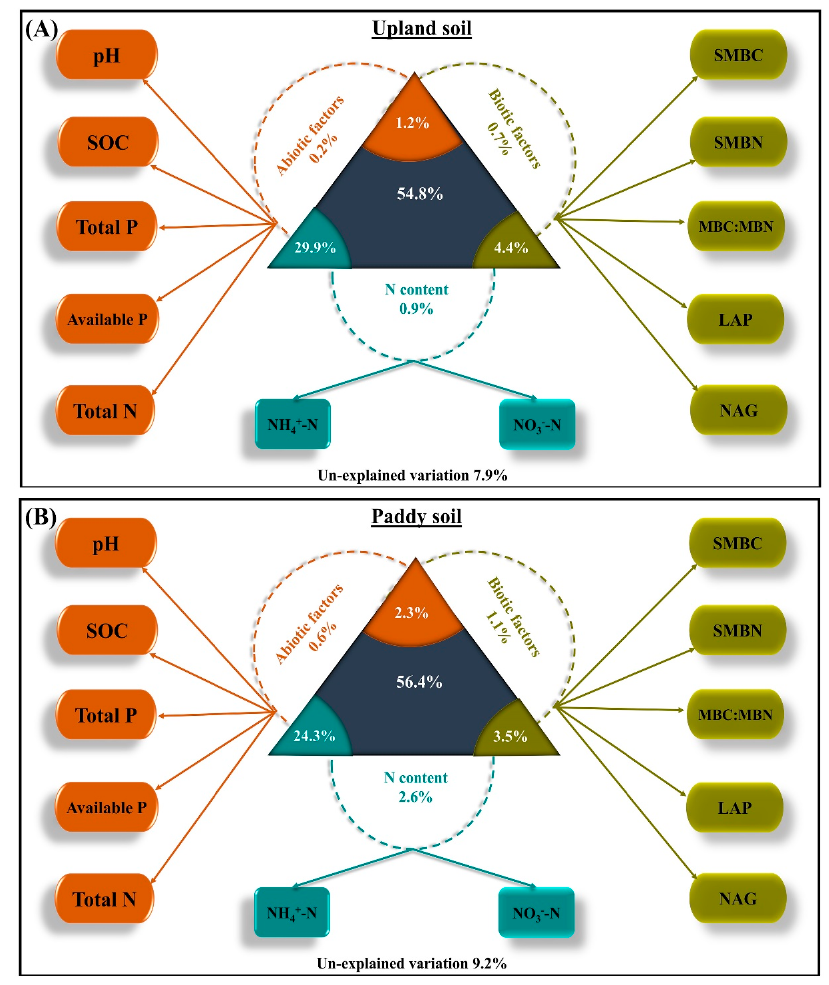
Figure 6. Venn diagrams showing the proportional contributions based on results from variation partitioning analysis (VPA), explaining the contribution of biotic factors, abiotic factors and N content to the net N mineralization in upland ( A ) and paddy soils ( B ). The effect of biotic factors (brown circle); the effect of abiotic factors (red circle); the effect of soil N content (blue circle); and their combined effects and respective variations explained are in areas overlapped by the different colored circles.